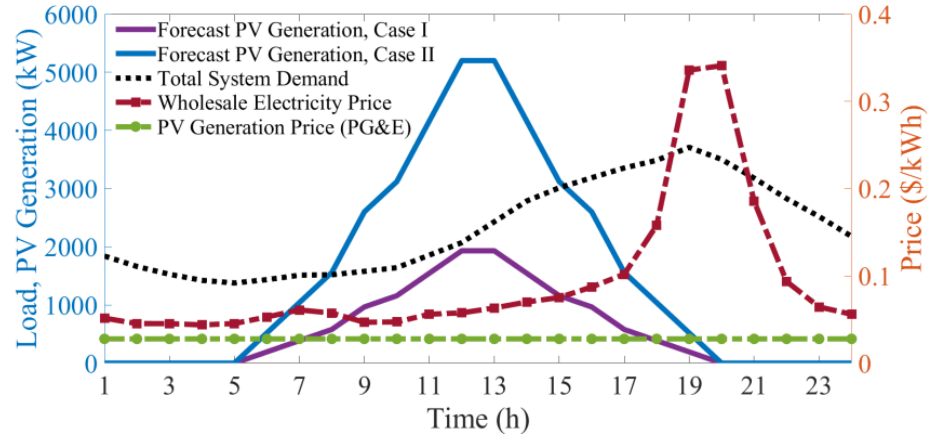
Figure 5. Forecast PV generation for Case I and II, total demand, wholesale power price, and PV power price.